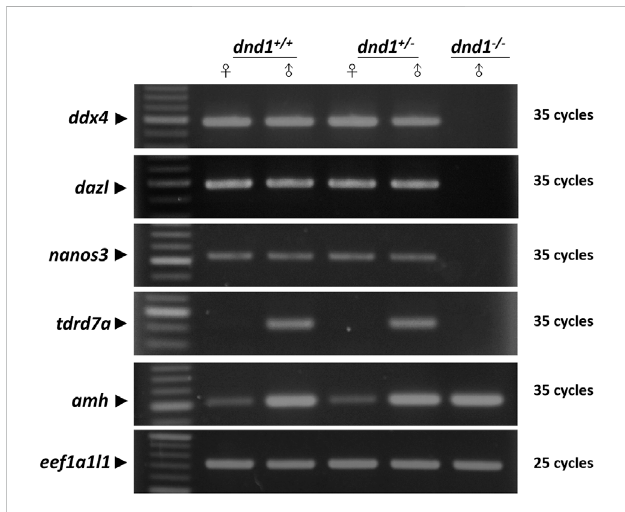
FIGURE 5 Analysis of the expression of germ-cell-related genes between the wild-type( dnd1 + / + ) ,heterozygous ( dnd1 + / − ) , andhomozygous ( dnd1 − / − ) mutant zebra fi sh through semi-quantitative